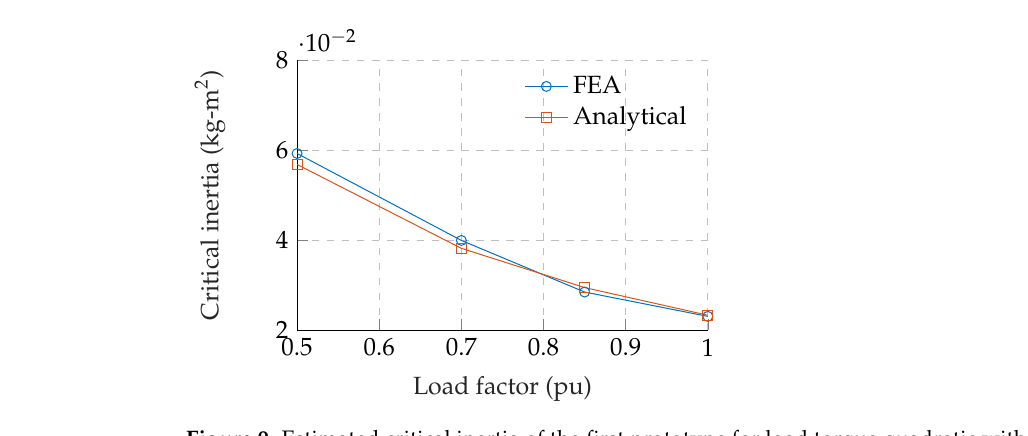
Figure 9. Estimated critical inertia of the first prototype for load torque quadratic with rotor velocity.